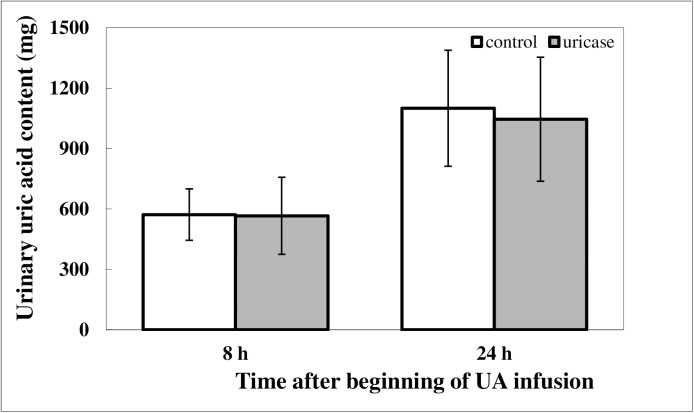
Urinary uric acid excretion in 9/10 nephrectomized pigs i.v. infused with a uric acid suspension (every 30 min for 7.5 h, 5 mg/kg b.w.), without (control period) or with (uricase treatment period) oral uricase treatment during the first 8 h and 24 h after beginning the uric acid infusions.Data are presented as means ± SD, n = 5 (each pig served as its’ own control).